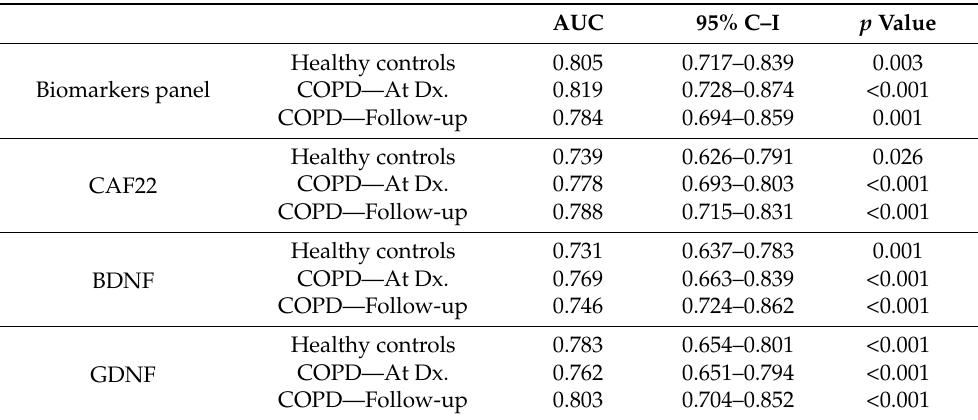
Table 2. The area under the curve (AUC) and confidence intervals for individual biomarkers and the biomarkers panel in healthy controls and patients with COPD at diagnosis (Dx) and follow-up ( n = 77–84/group).